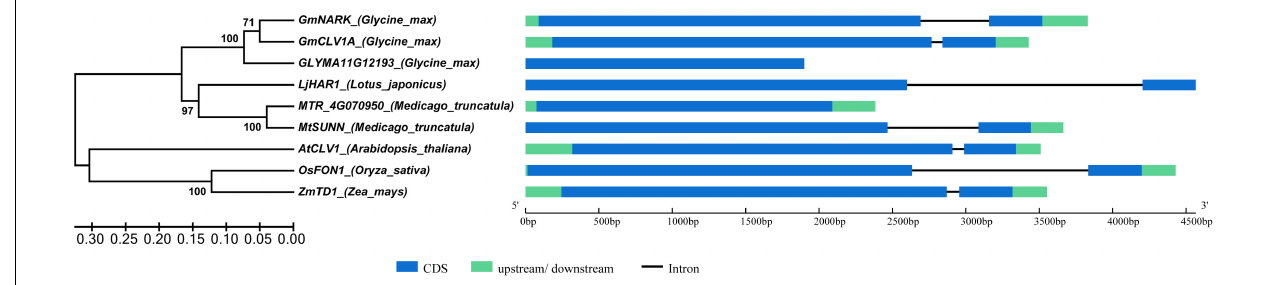
FIGURE 1 | Phylogenetic tree of GmNARK and its homologs in related species. The homologs of GmNARK in related species were obtained by the analysis in website of PLAZA 3.0. The gene sequences were downloaded from the JGI database and each of gene locus names were as follows: GmNARK ( Glyma.12G040000 ), GmCLV1A ( Glyma.11G114100 ), GLYMA11G12193 ( Glyma.11G114200 ), LjHAR1 ( chr3.CM0091.1690.r2.m , the NCBI identity document), MTR_4g070950 ( Medtr4g070950 ), MtSUNN ( Medtr4g070970 ), AtCLV1 ( AT1G75820 ), OsFON1 ( LOC_Os06g50340 ), ZmTD1 ( GRMZM2G300133 ). Bootstrap consensus of the phylogenetic tree inferred from 1000 replicates using the neighbor-joining method.